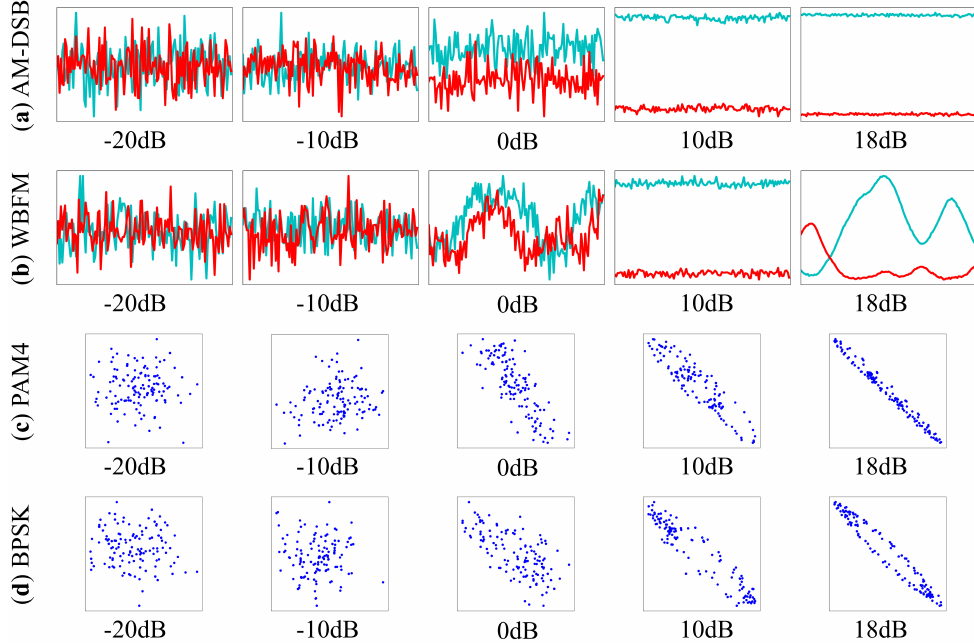
Figure 4. IQ components examples of ( a ) AM-DSB and ( b ) WBFM, constellation diagram examples of ( c ) PAM4 and ( d ) BPSK with SNR = − 20 dB, − 10 dB, 0 dB, 10 dB, and 18 dB. The cyan line shows the in-phase component while the red line shows the quadrature